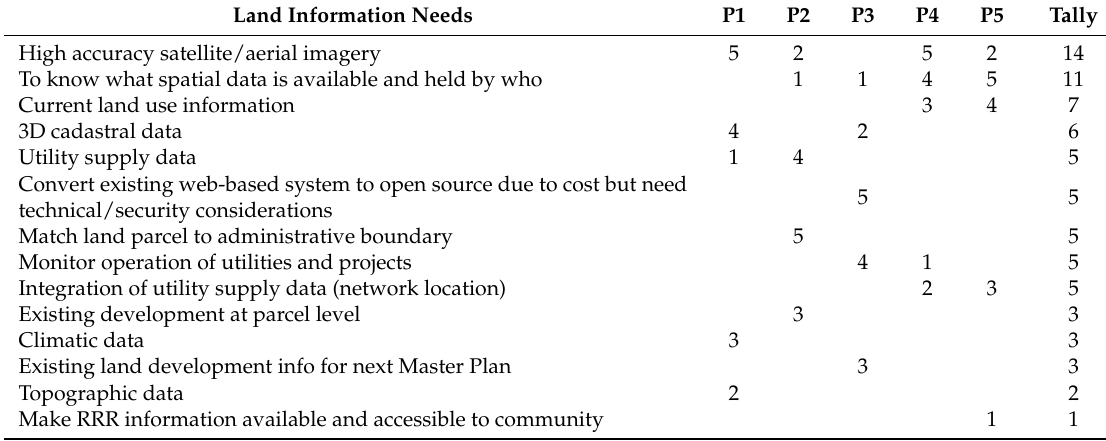
Table 3. Example of NGT workshop outcome in the project (five participants, second round voting). Land Information Needs High accuracy satellite/aerial imagery